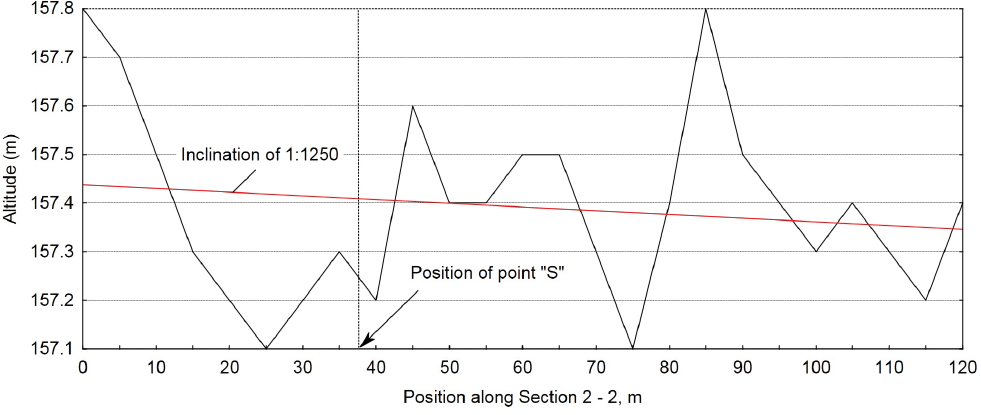
Figure 10. Longitudinal section of the trench (see Section 2–2 in Figure 7) (the altitudes were obtained by using the Maps.lt